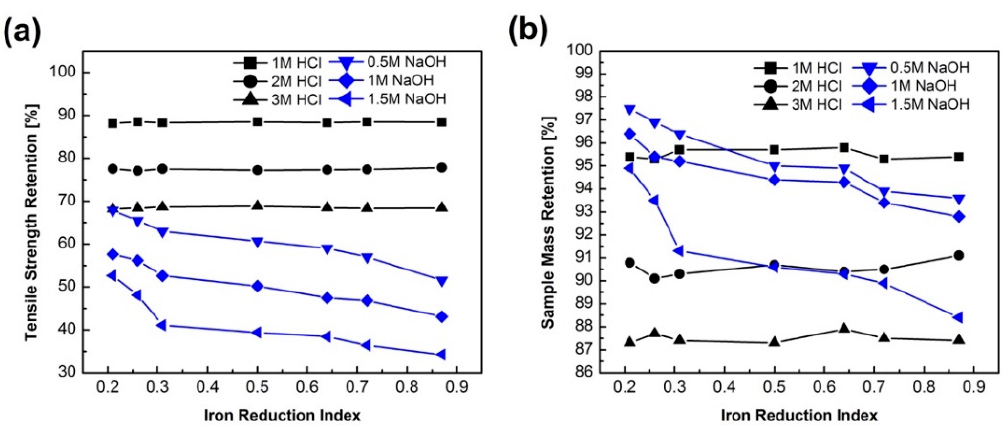
Figure 4. ( a ) Tensile strength retention of basalt fiber samples after alkali corrosion; ( b ) mass retention of basalt fiber samples after acid corrosion.